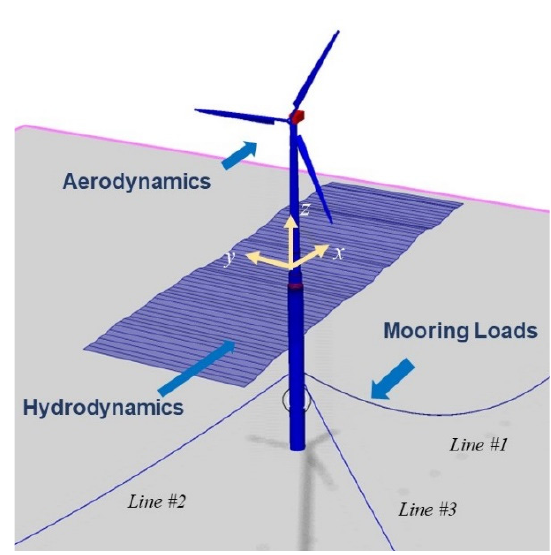
Figure 1. Definition of the physical problems. Table 1. Parameters of the NREL 5 MW wind